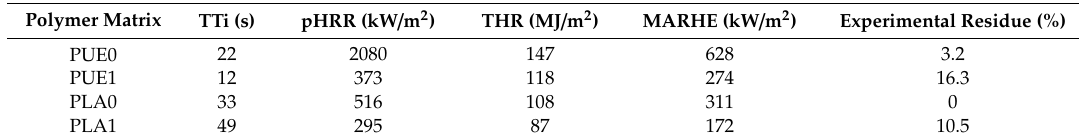
Table 3. Cone calorimeter results for PUE/APP and PLA/APP composites.